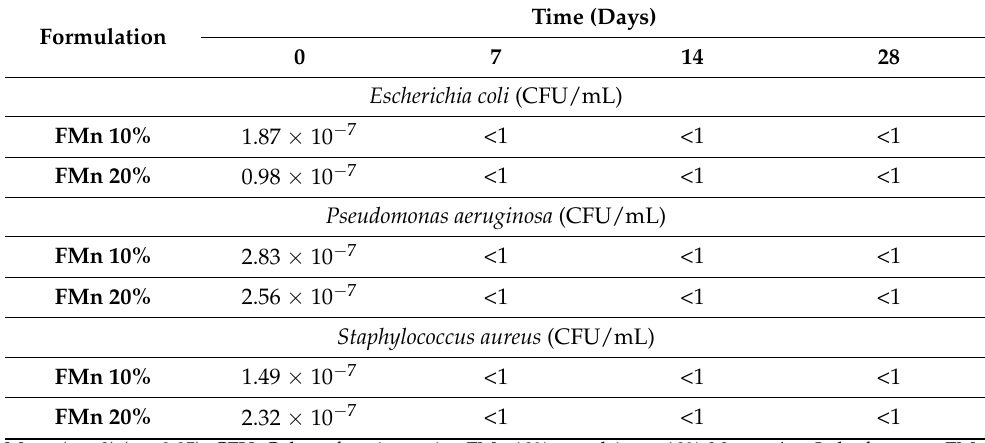
Table 3. Emulsions containing extract of Morus nigra . Challenge test—microbial load count in aerobic plates—period: 28 days. Time (Days) Formulation Escherichia coli (CFU/mL)